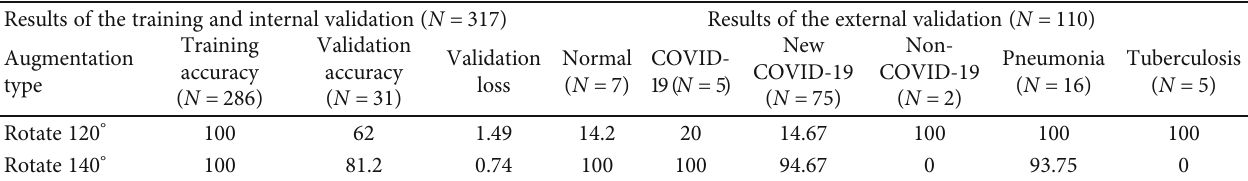
Table 3: Performance of augmented image-based models on training, internal validation, and external validation images. Results of the training and internal validation ( N = 317 ) Results of the external validation ( N = 110 )